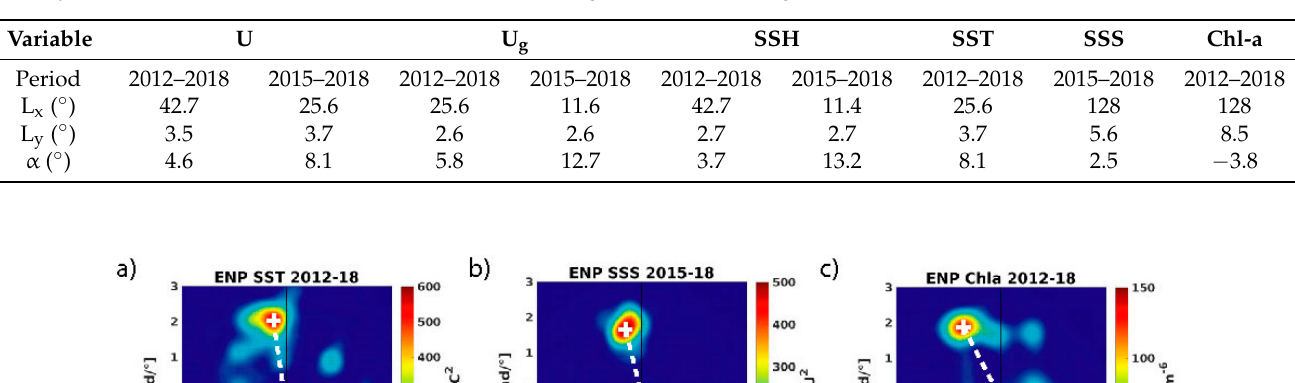
Table 2. Zonal and meridional wavelengths (L x , L y ), and the striation angle ( α ) associated with surface tracers and the dynamical fields determined from 2-D FFT in the ESP (Figure 5). Positive/negative α values are clockwise/counterclockwise.